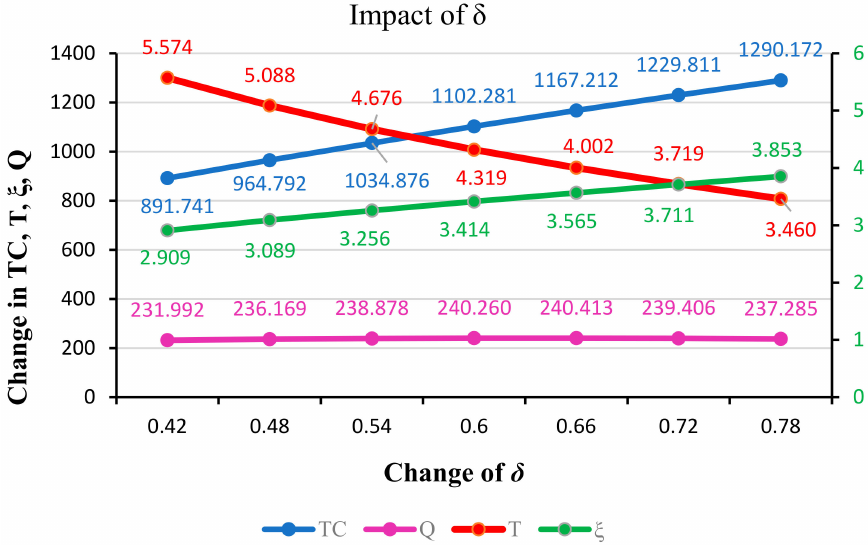
Figure 7. The relationship among δ and TC, T, ξ , Q